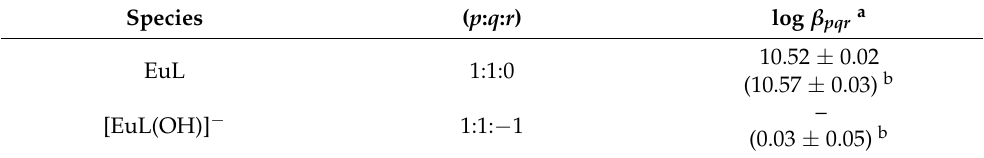
Figure 6. ( a ) Experimental absorption spectra of Eu 3+ /CFA system at 1:1 ratio, measured at different pH values, c CFA = 4 × 10 − 5 mol ∙ dm − 3 , in I = 0.2 mol ∙ dm − 3 KCl (aq) and T = 298.15 K; ( b ) calculated molar absorbance spectra for the [EuL] and [EuL(OH)] − species. Table 5. Eu(IIII)/CFA complex formation constants in KCl (aq) at I = 0.2 mol ∙ dm − 3 and T = 298.15 K.